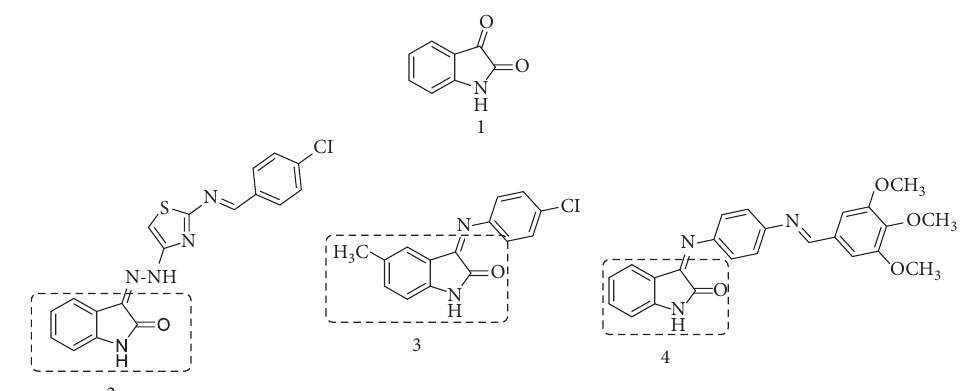
Figure 1: Chemical structures of the promising anticonvulsant isatin derivative.